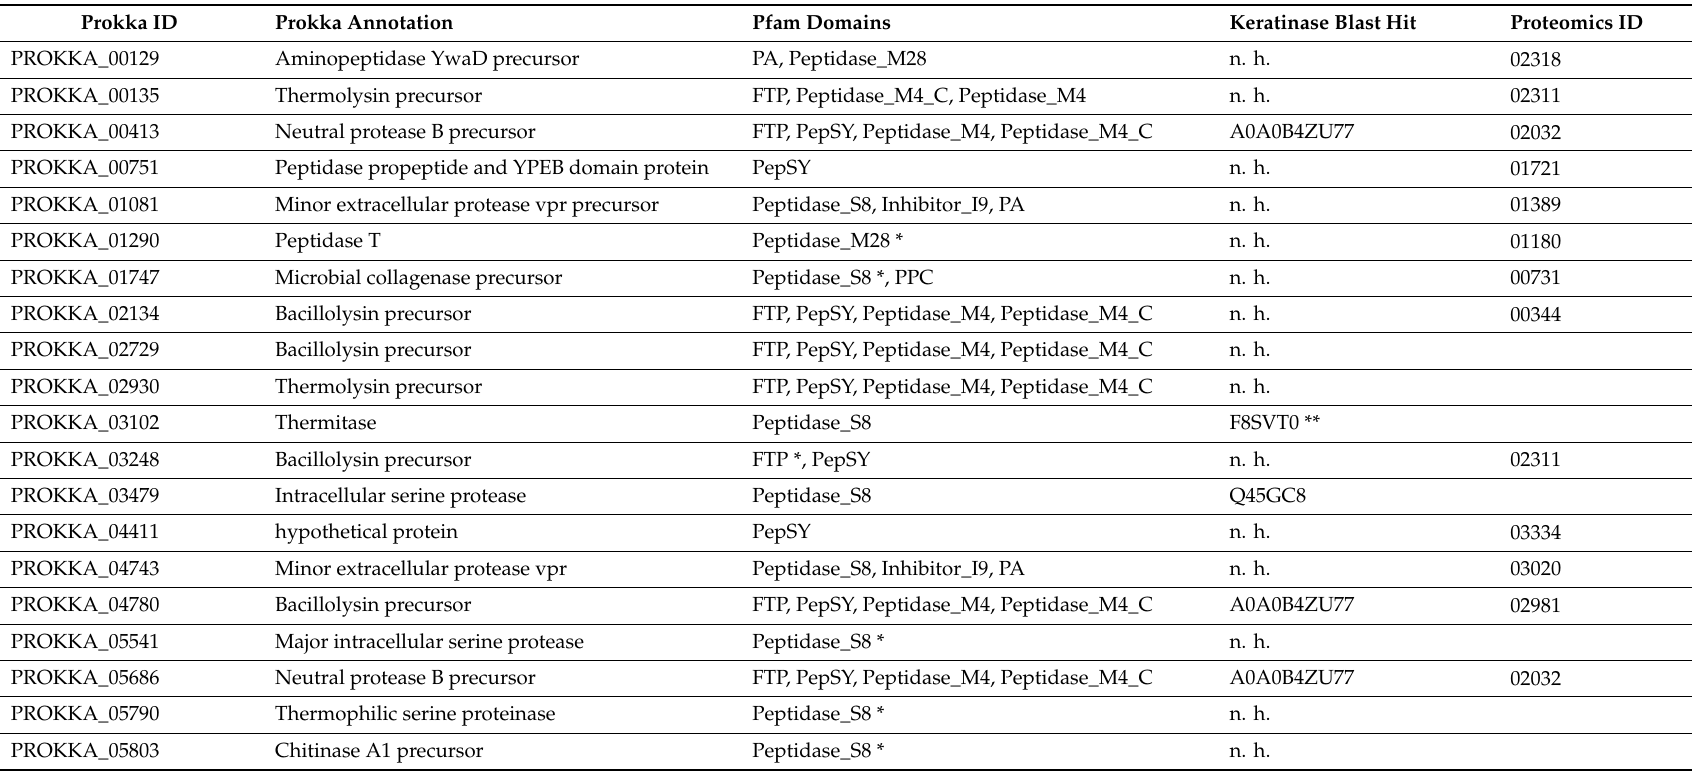
Table 3. Predicted genes of Bac18 that include Pfam domains related to